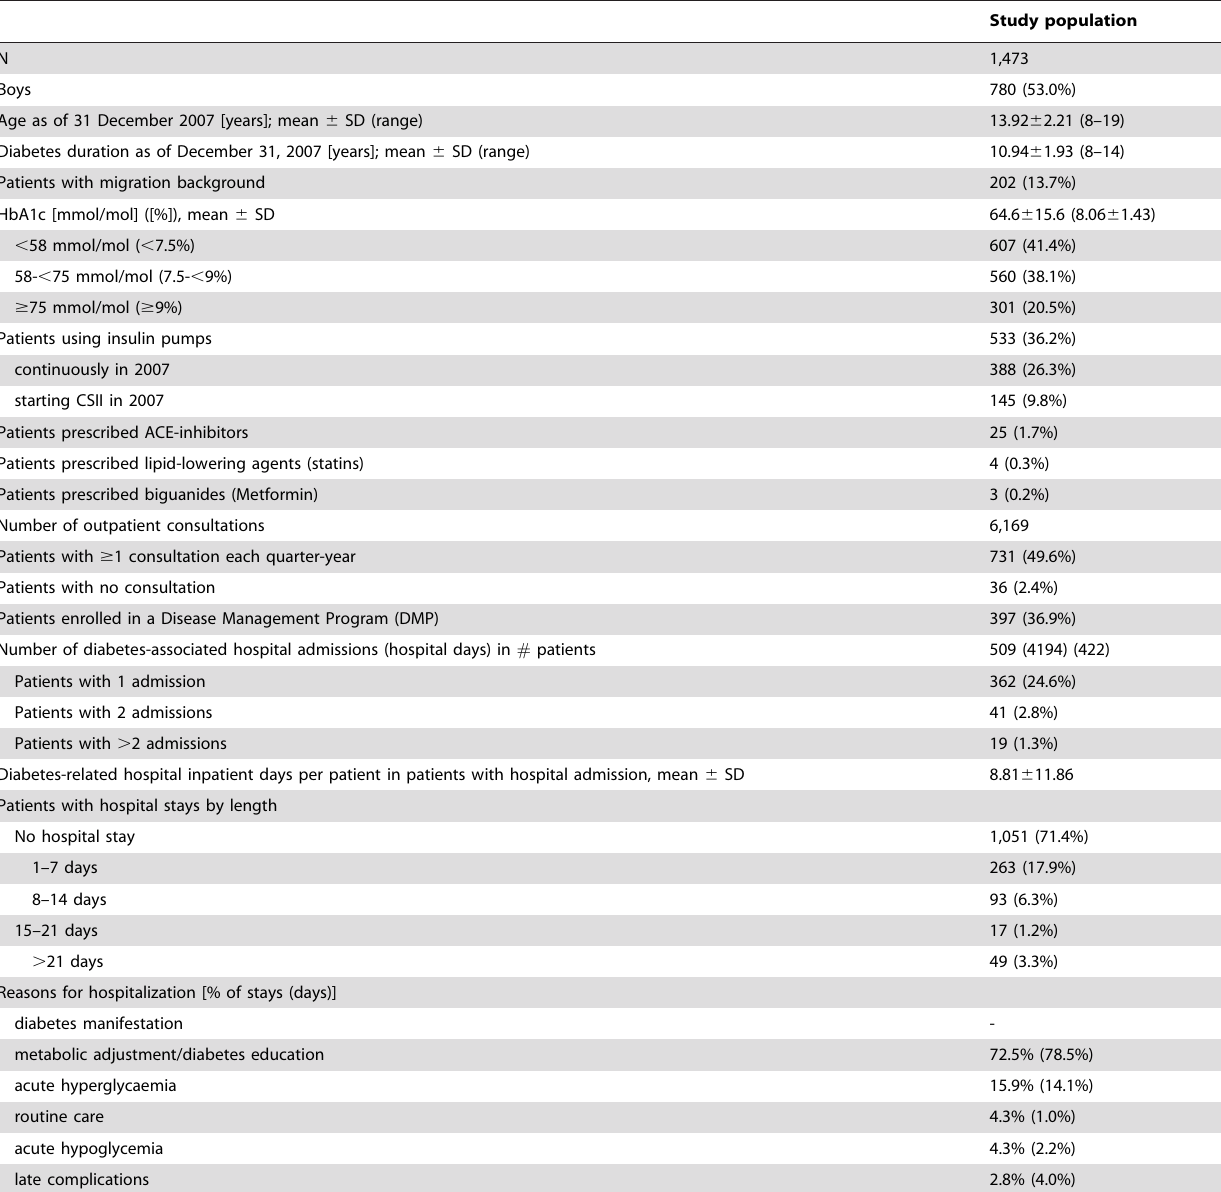
Table 2. Description of the study population